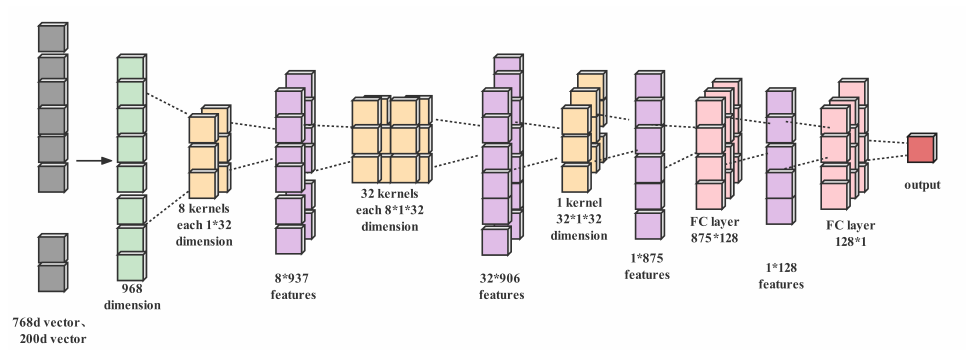
Figure 5. The flow of the whole